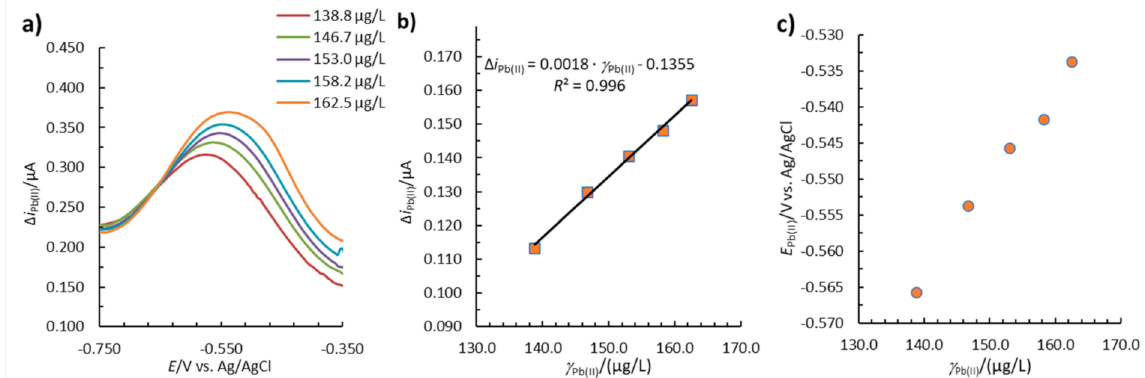
Figure 2. ( a ) Voltammograms measured for the BiFSPE at different γ Pb(II) for a single drop placed on the SPE holder, ( b ) the linear concentration range, and ( c ) the change in E Pb(II) vs. γ Pb(II) . The measurements were performed at E acc = − 1.5 V and t acc = 60 s in 0.1 M acetate buffer containing 0.5 mg/L